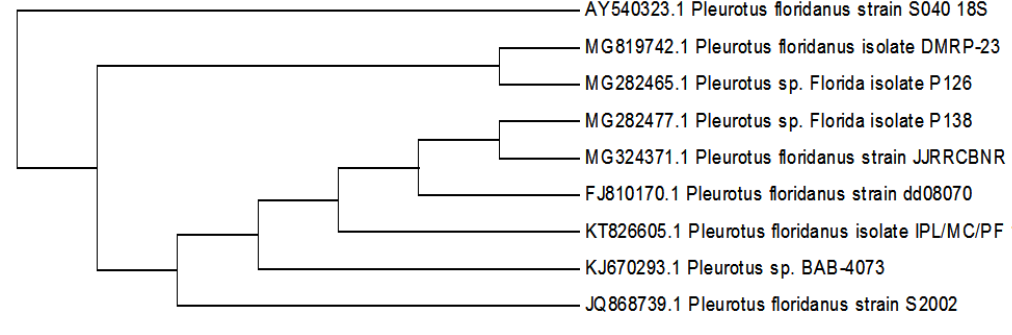
Fig. 3. Phylogenetic tree of